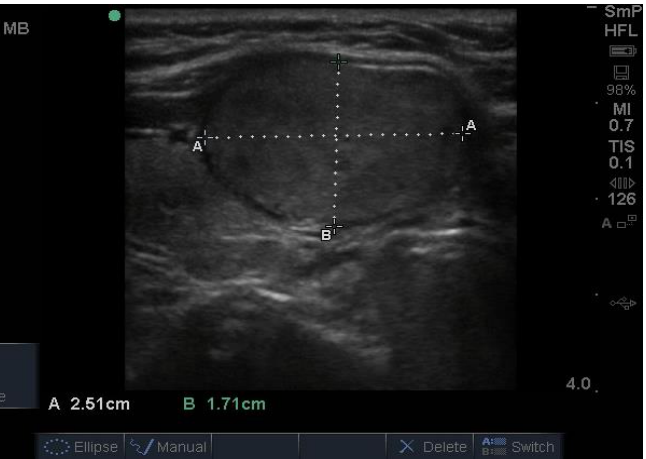
Figure 2. Thyroid ultrasound from a patient with a nodule that was shown to be benign on biopsy. The nodule is isogenic, wider than tall, with a sharp edge and halo.